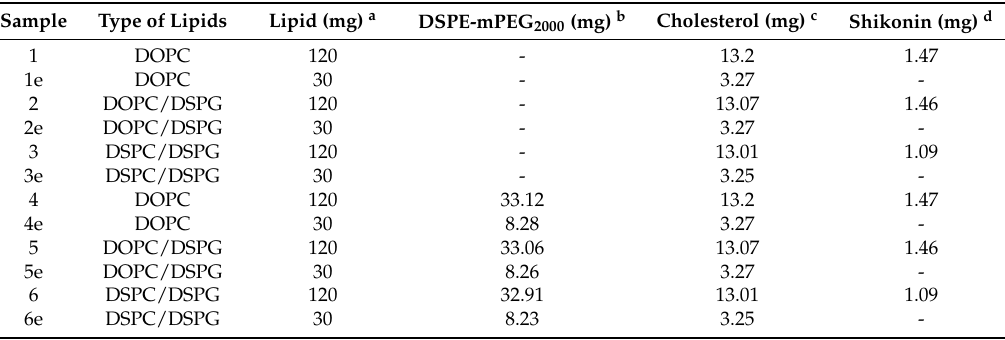
Table 1. Liposome compositions used in the